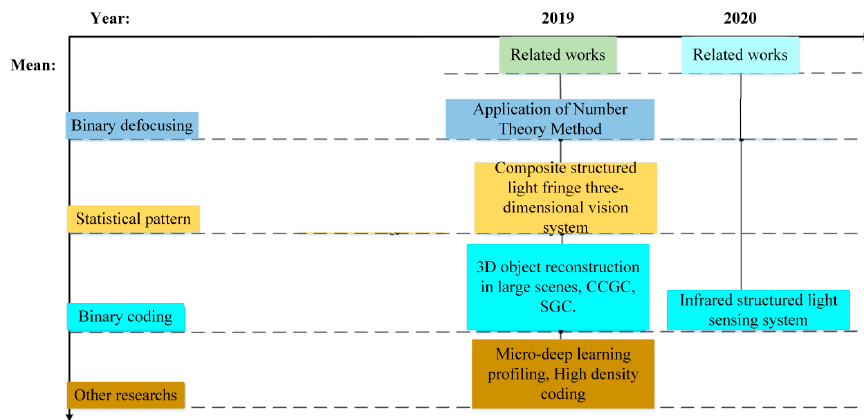
Figure 7. Technology timeline.